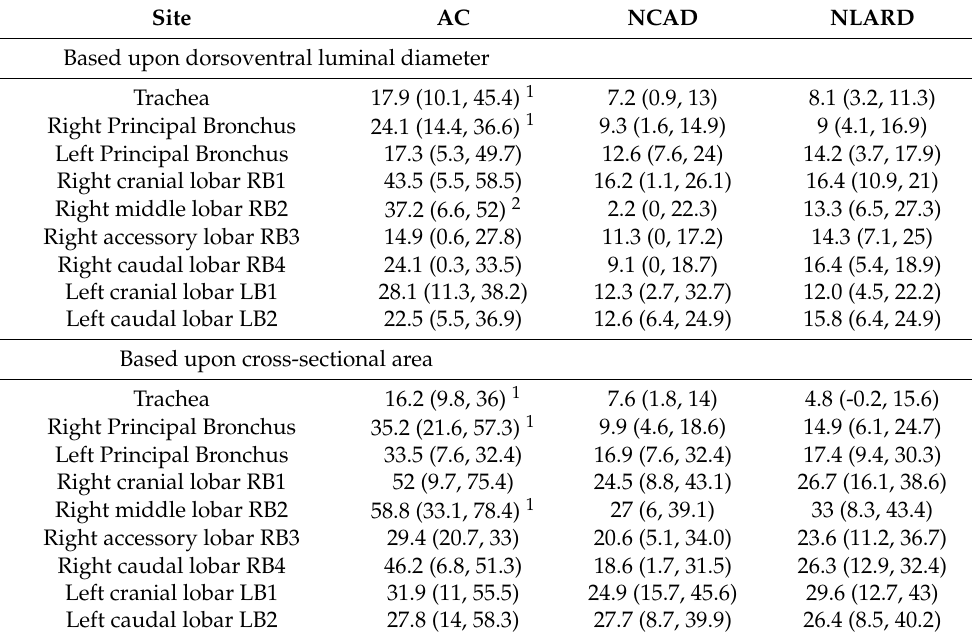
Table 3. Percentage of dynamic airway narrowing (median (interquartile range (IQR))) in dogs with airway collapse (AC), with non-collapsible inflammatory airway disease (NCAD) and non-lower airway respiratory disease (NLARD) based on diameter and cross-sectional area measured on paired inspiratory/expiratory breath-hold CT